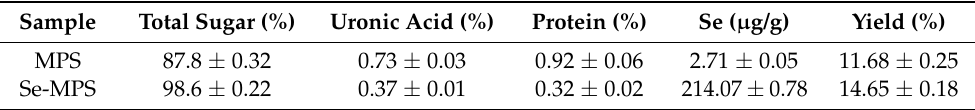
Table 1. Preliminary chemical composition of Morel polysaccharide (MPS) and Se-enriched Morel polysaccharide